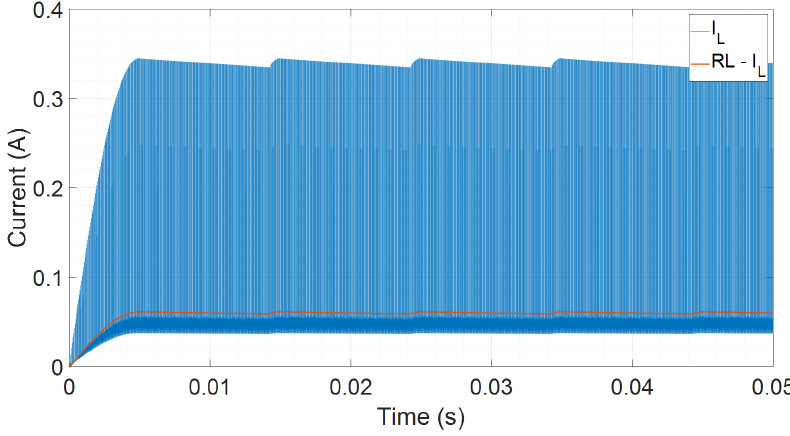
Figure 6. Current Waveform Comparison—Load.